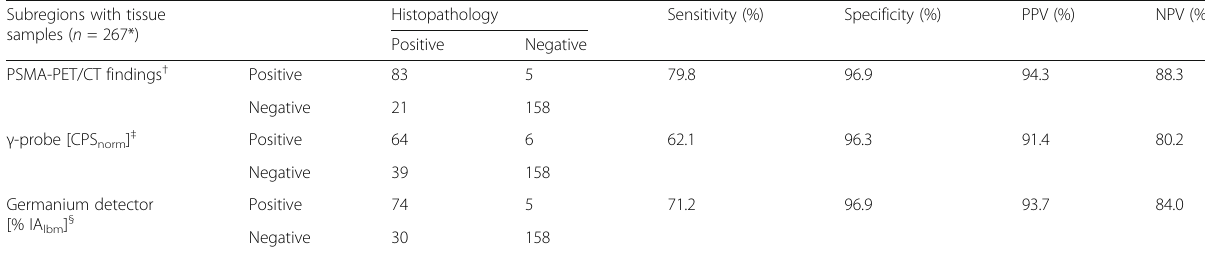
Table 4 Agreement between PSMA-PET/CT, γ -probe, germanium detector and histopathology in 267 subregions Subregions with tissue samples ( n =